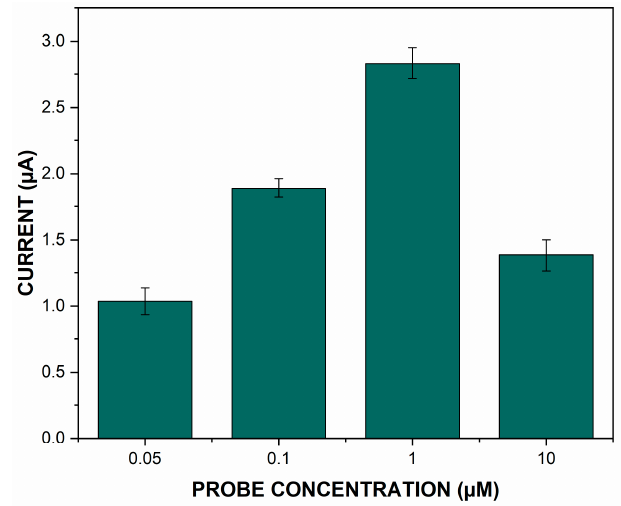
Figure 6. Differential pulse voltammetry reduction current of MB on CysAm/AuNPs/CB/PGE after immobilization of different concentrations of the ssDNA capture probe from 0.05 to 10 µ M (RSD% = 9.69%, 3.81%, 4.18%, 8.68%). Incubation in 20 µ M MB at Tris-HCl buffer (20 mM, pH 7.00) including 20 mM NaCl for 5 min and washing with the same buffer including 20 mM NaCl (n = 3). The capture probe concentration of 0.1 µ M shows no significant difference before and after hybridization with 10, 50, and 500 nM of microRNA-21 target sequence concentra- tions (Figure 7A). This result could be attributed to the small amount of the immobilized ssDNA capture probe, which does not allow good hybridization even under the saturating concentration of microRNA-21. The ssDNA capture probe concentration of 1 µ M shows a significant and proportional difference (Figure 7B). This is due to the sufficient concentration of the ssDNA capture probe, which allows a good and efficient hybridization with microRNA-21 target sequence concentrations. The ssDNA probe concentration of 1 µ M was selected as the optimal capture probe concentration according to the MB reduction current obtained results.